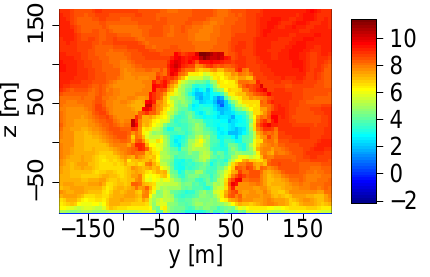
Figure 21. Snapshot of the spectral model with added small-scale turbulence (Figure 20) in the wake and ambient ABL turbulence outside the wake structure.